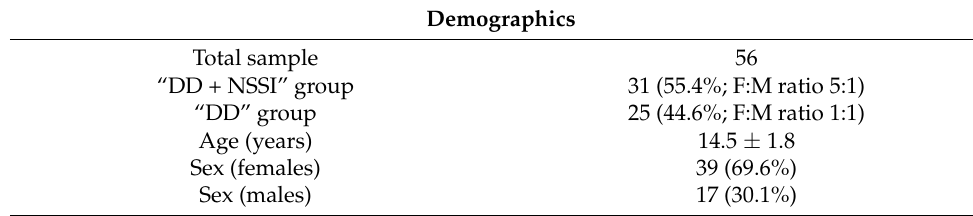
Table 1. Descriptive statistics of demographic and clinical